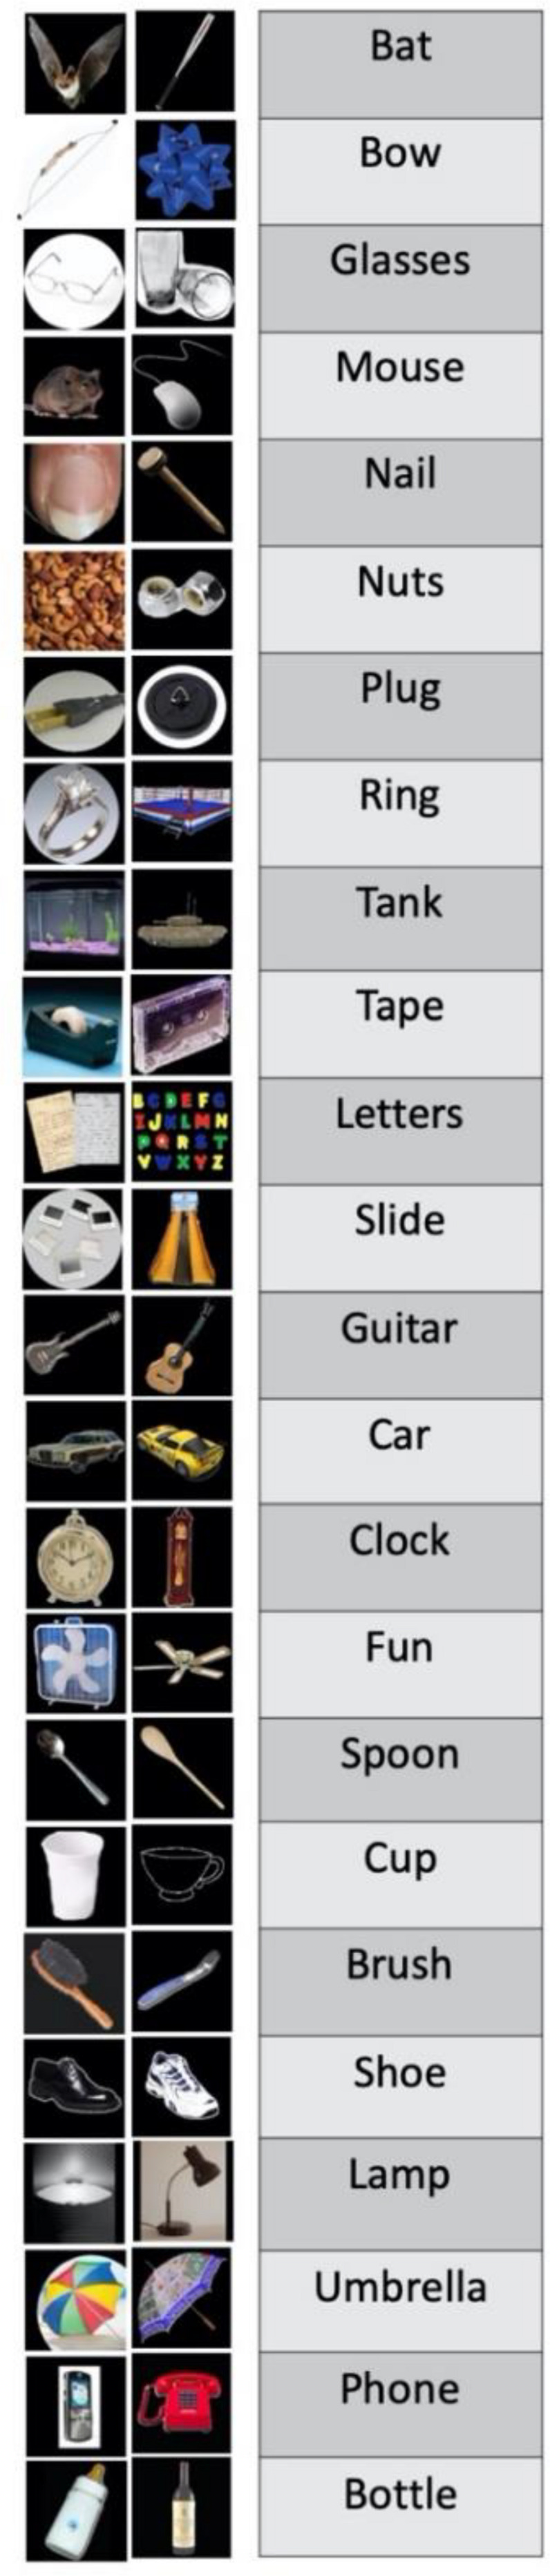
List of referential competitors materials.